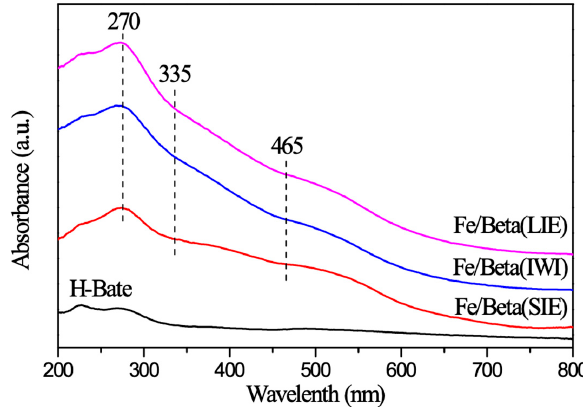
Figure 5. UV-vis spectra of H-Beta and Fe/Beta catalysts.